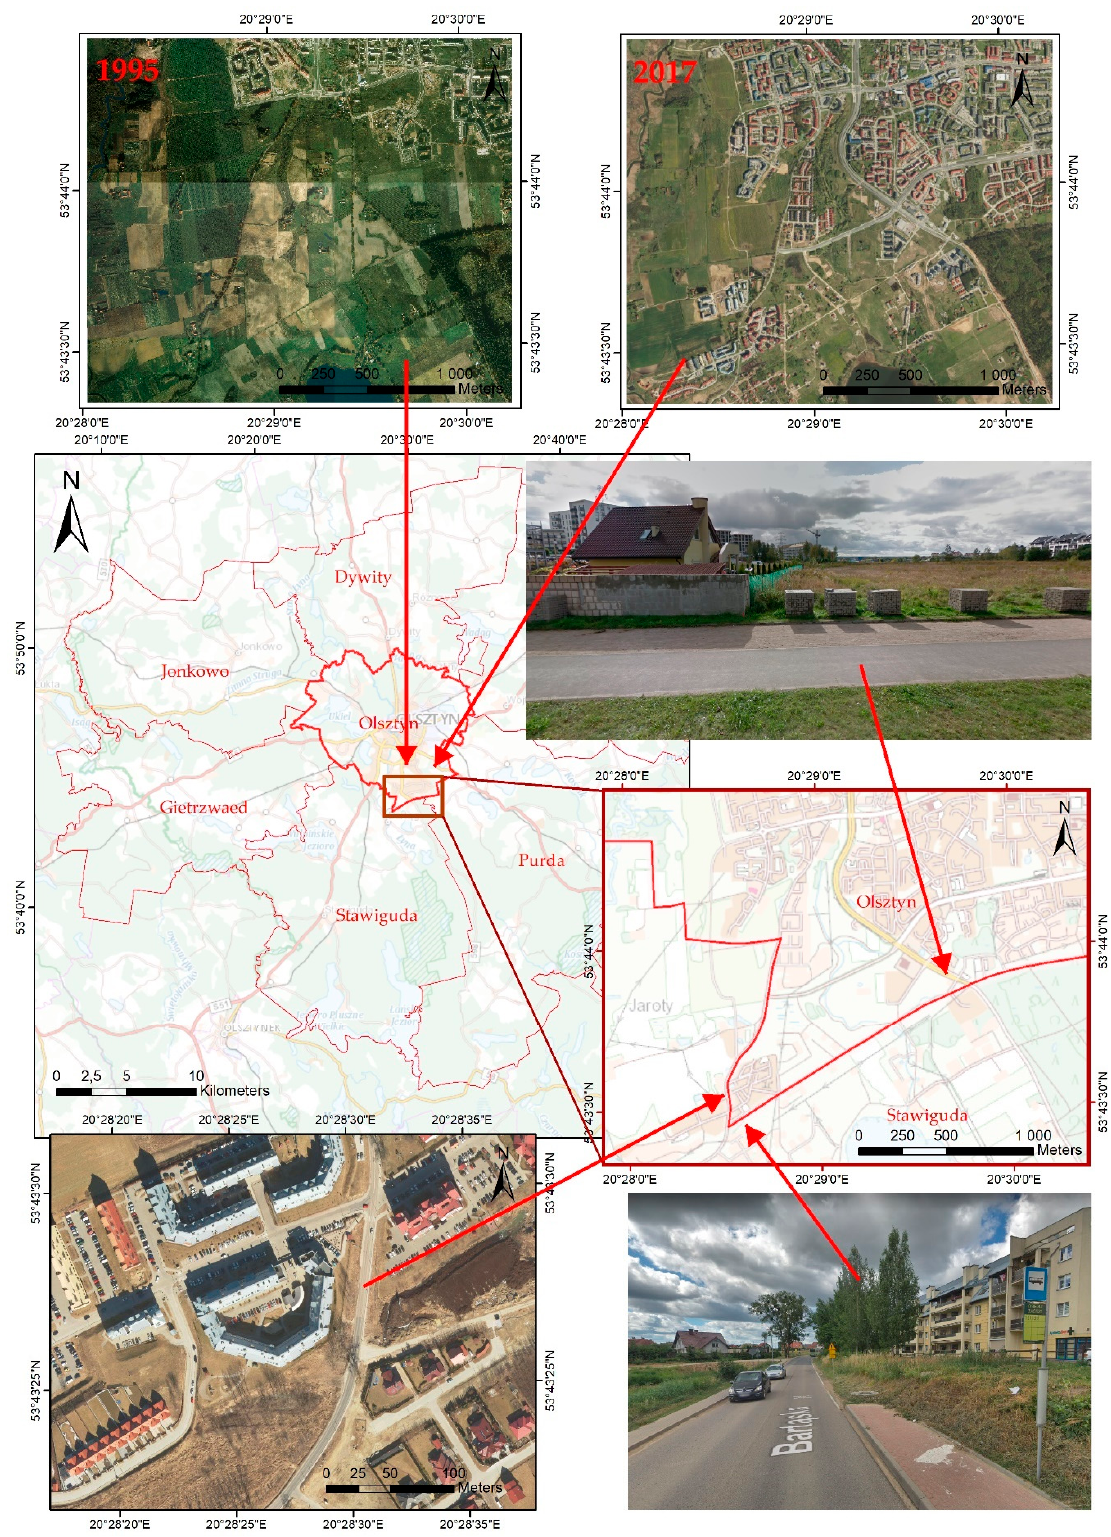
Figure 1. Progressive development in the suburban zone–southern part of the Olsztyn city in the Region of Warmia and Mazury, Poland. Source: own elaboration.